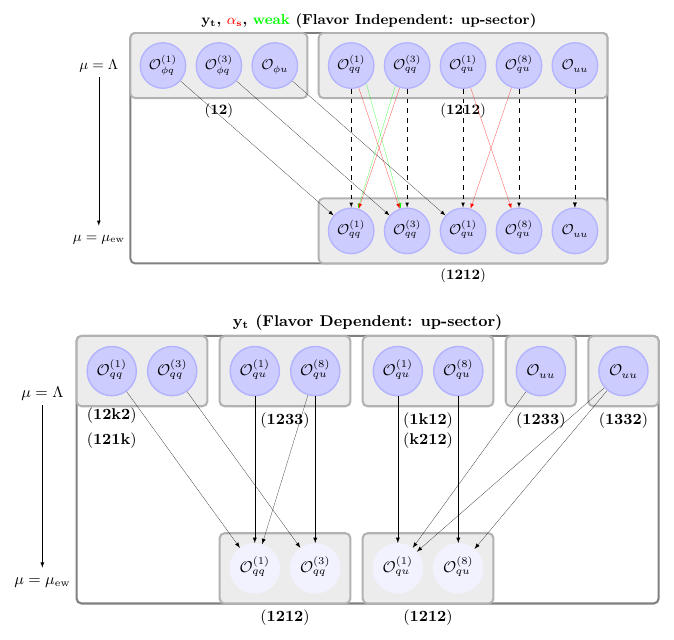
Figure 3 . Mixing of operators relevant for ∆ F = 2 observables for D 0 − ¯ D 0 -mixing in the Warsaw down-basis. The red, green and black lines indicate the mixing due to strong, electroweak and top-Yukawa couplings, respectively. Here k = 1 , 2 , 3 . The self-mixing is shown by a dashed black line. For the up-basis the mixing due to top-Yukawa, i.e. all black lines